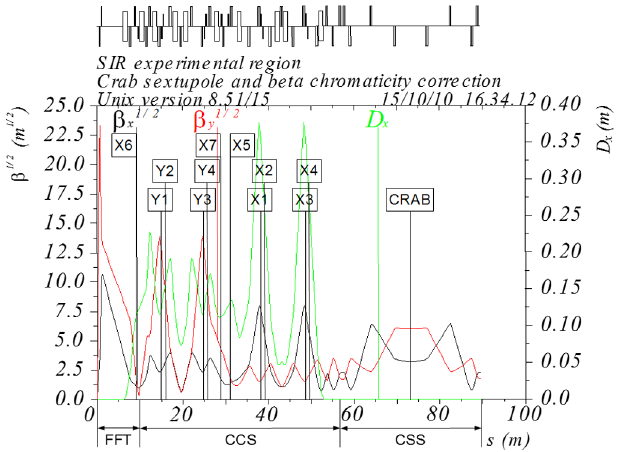
FIG. 10. Optical functions of FCC-ee interaction region variant